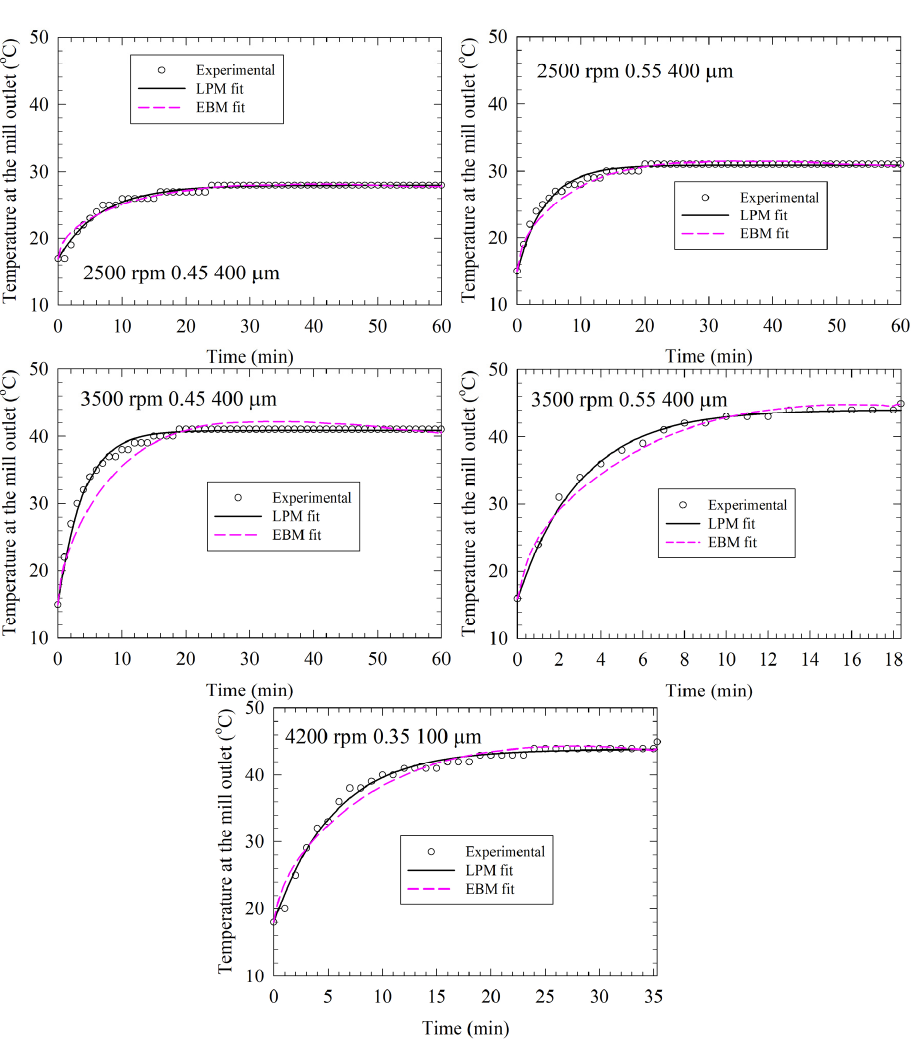
Figure 6. Direct fitting of the experimental temperature profiles via the lumped parameter model (LPM) and the enthalpy balance model (EBM) for the test runs (Runs 28–32). The EBM fits were taken from Guner et al. (2022) [33]. Table 3. Parameters of the LPM estimated by direct fitting as well as predicted using the PL and ML models coupled to the LPM along with the associated statistics.